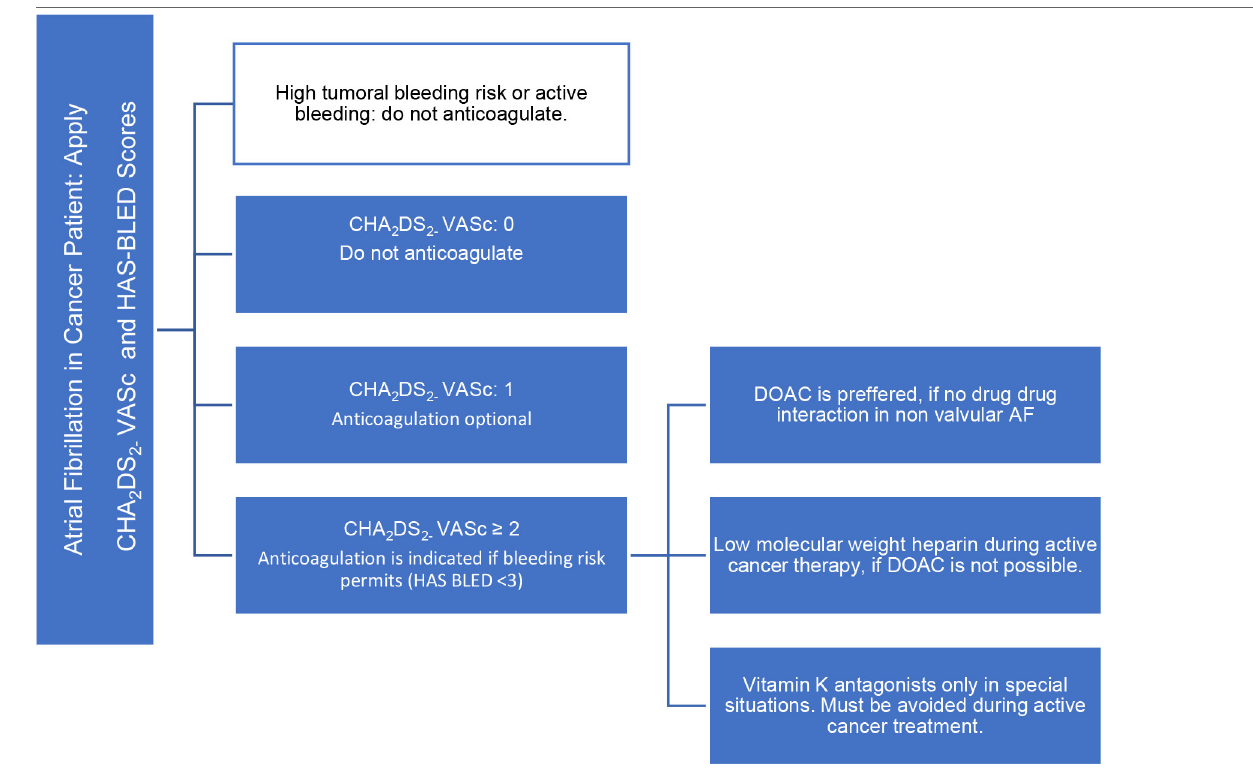
TABLE 2 | Thromboembolic and bleeding risk assessment